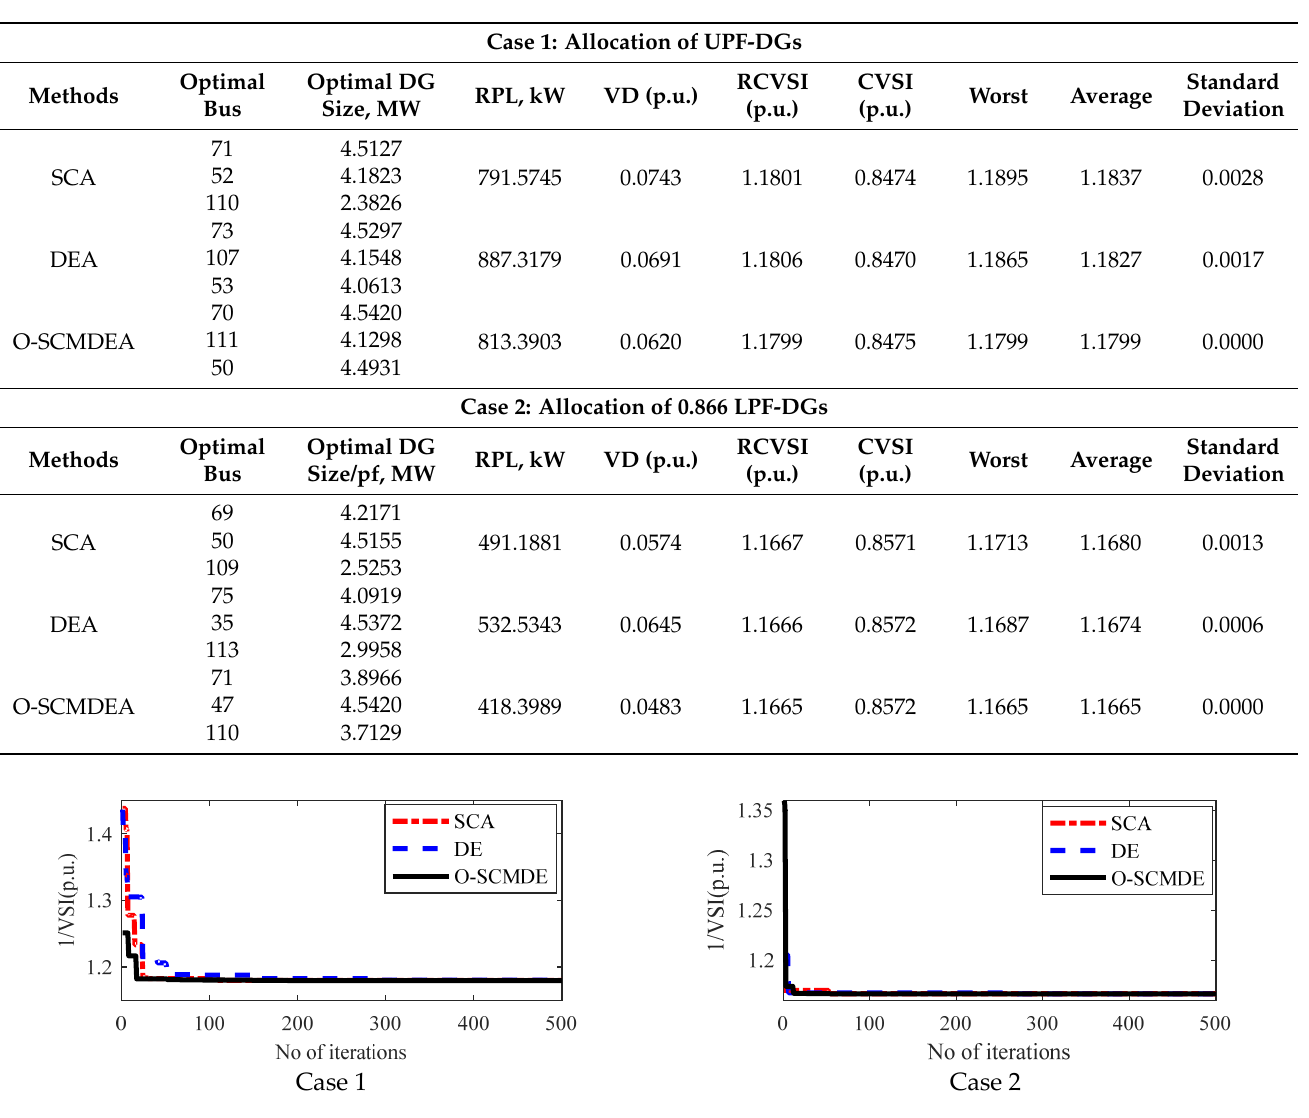
Table 10. Comparison of the results for the RCVSI minimization of 118 bus DN.